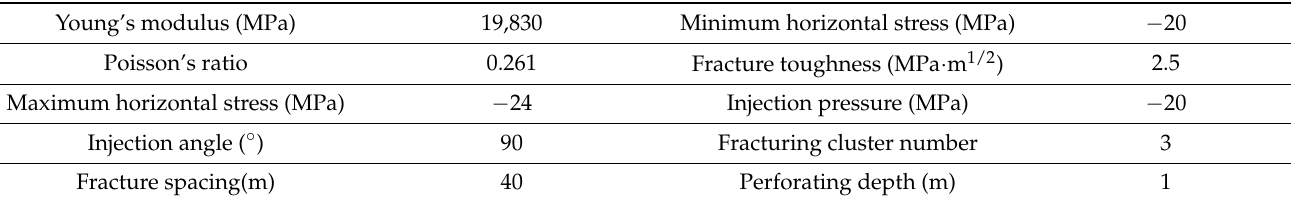
Table 2. Initial simulation parameters.